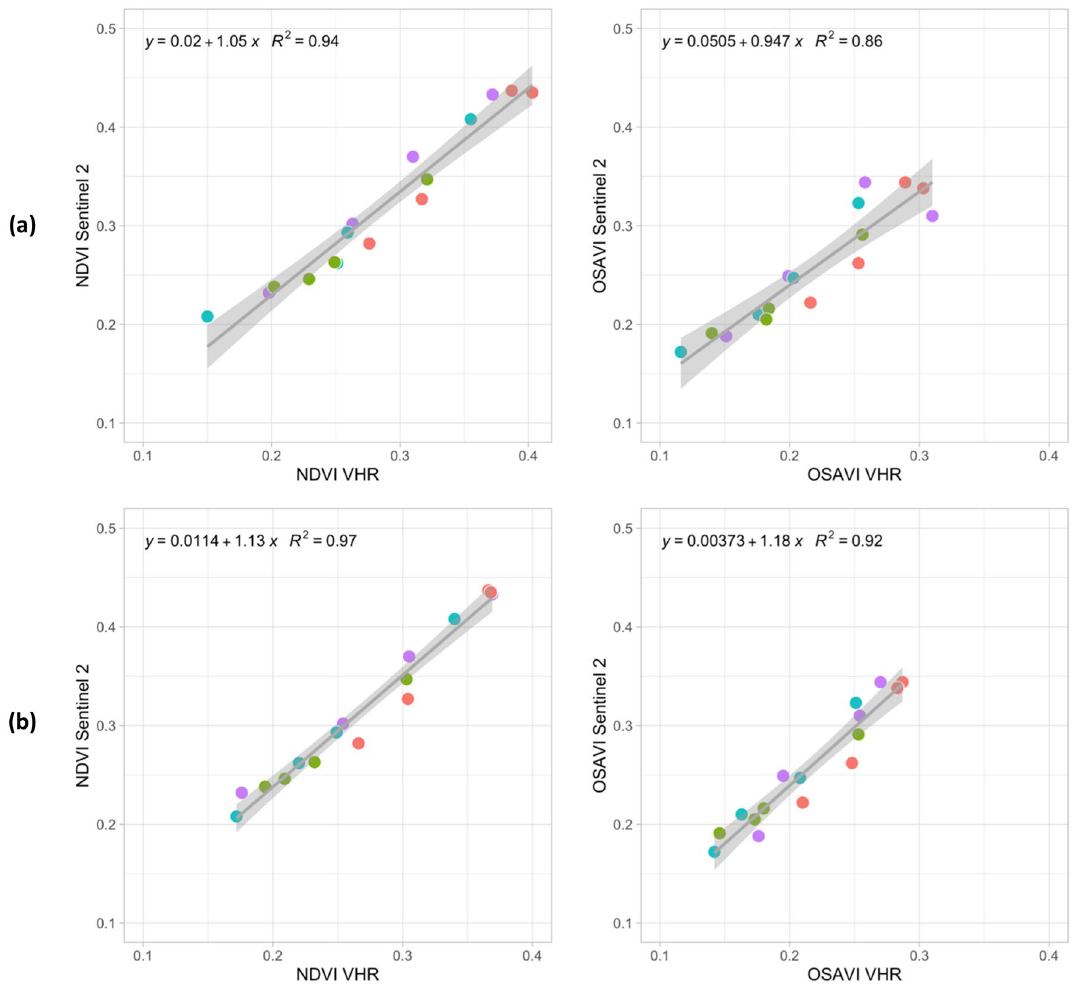
Figure 15. Scatterplot of NDVI and OSAVI field mean values from S-2 and ( a ) index mean values from only tree crown pixels from Pléiades images; ( b ) index mean values all over Pléiades pixels from available treated and not treated